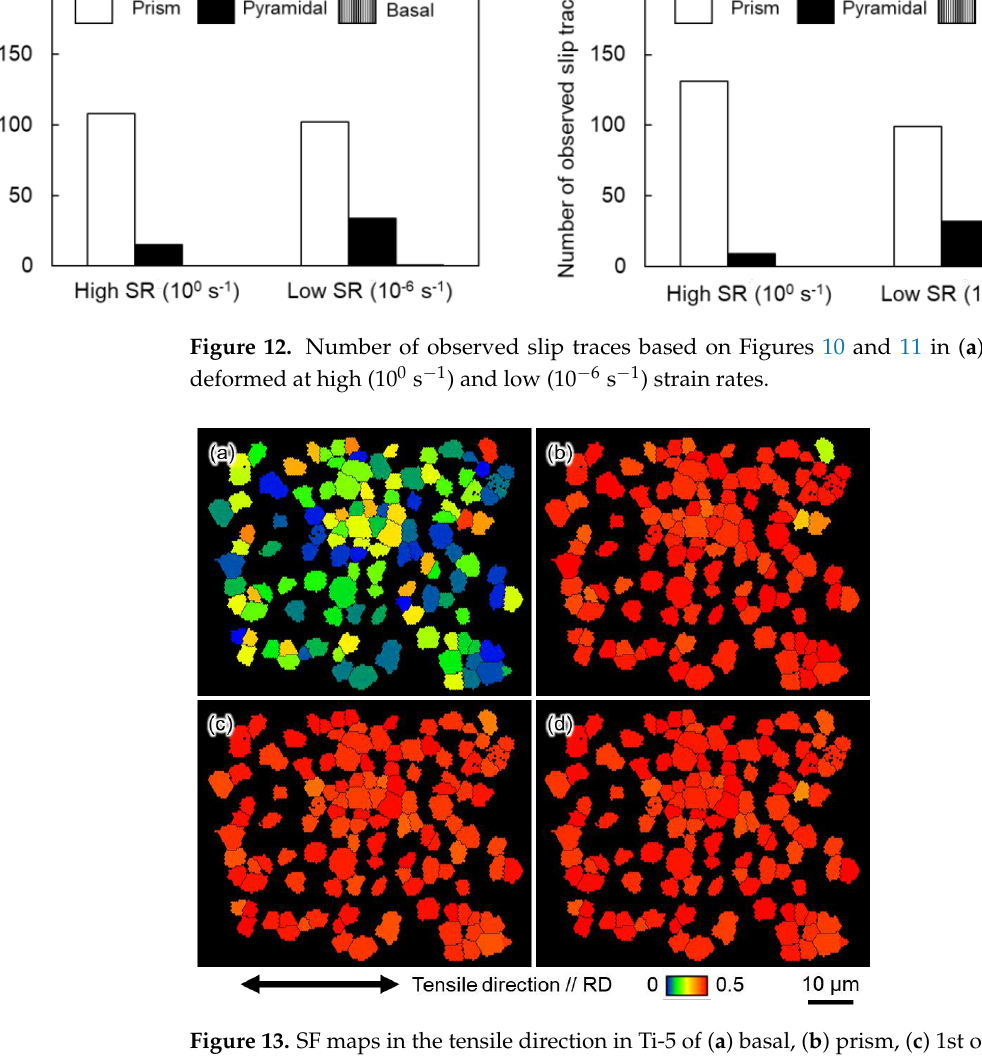
Figure 13. SF maps in the tensile direction in Ti-5 of ( a ) basal, ( b ) prism, ( c ) 1st order pyramidal ⟨𝑎⟩ , and ( d ) 1st order pyramidal ⟨𝑎 + 𝑐⟩ dislocation slips.